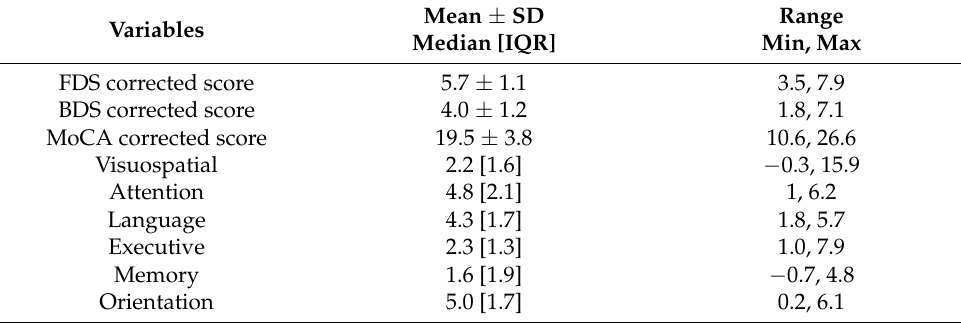
Table 2. Neuropsychological Test results of the study sample.